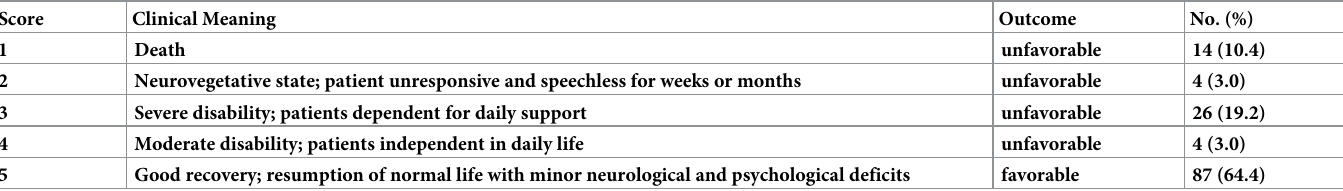
Table 1. The Glasgow outcome scales of the patients in this